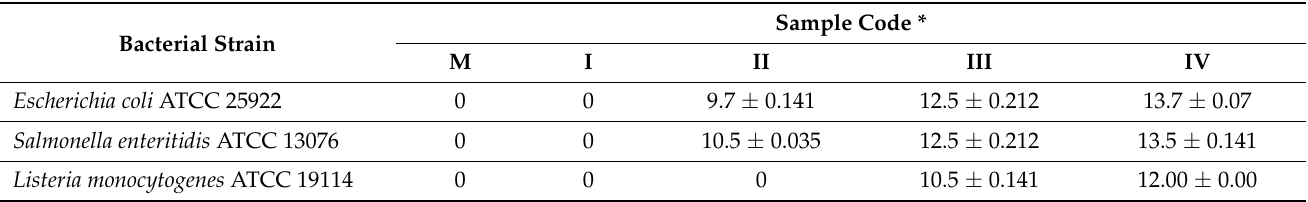
Table 3. Diameters of inhibition zones (mm) for tested hydrogel